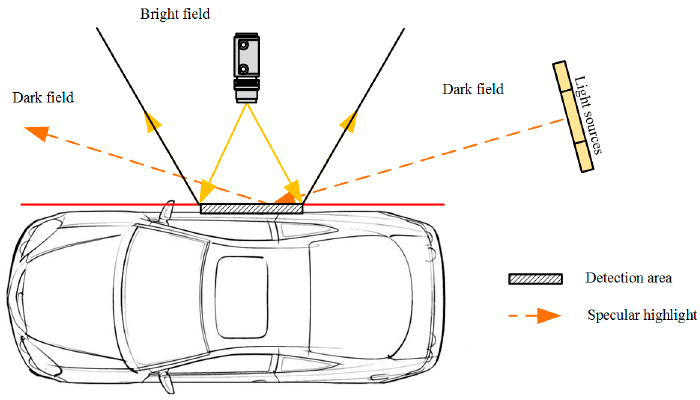
Figure 1. Sketch of dark field Figure 1 . Sketch of dark field illumination.